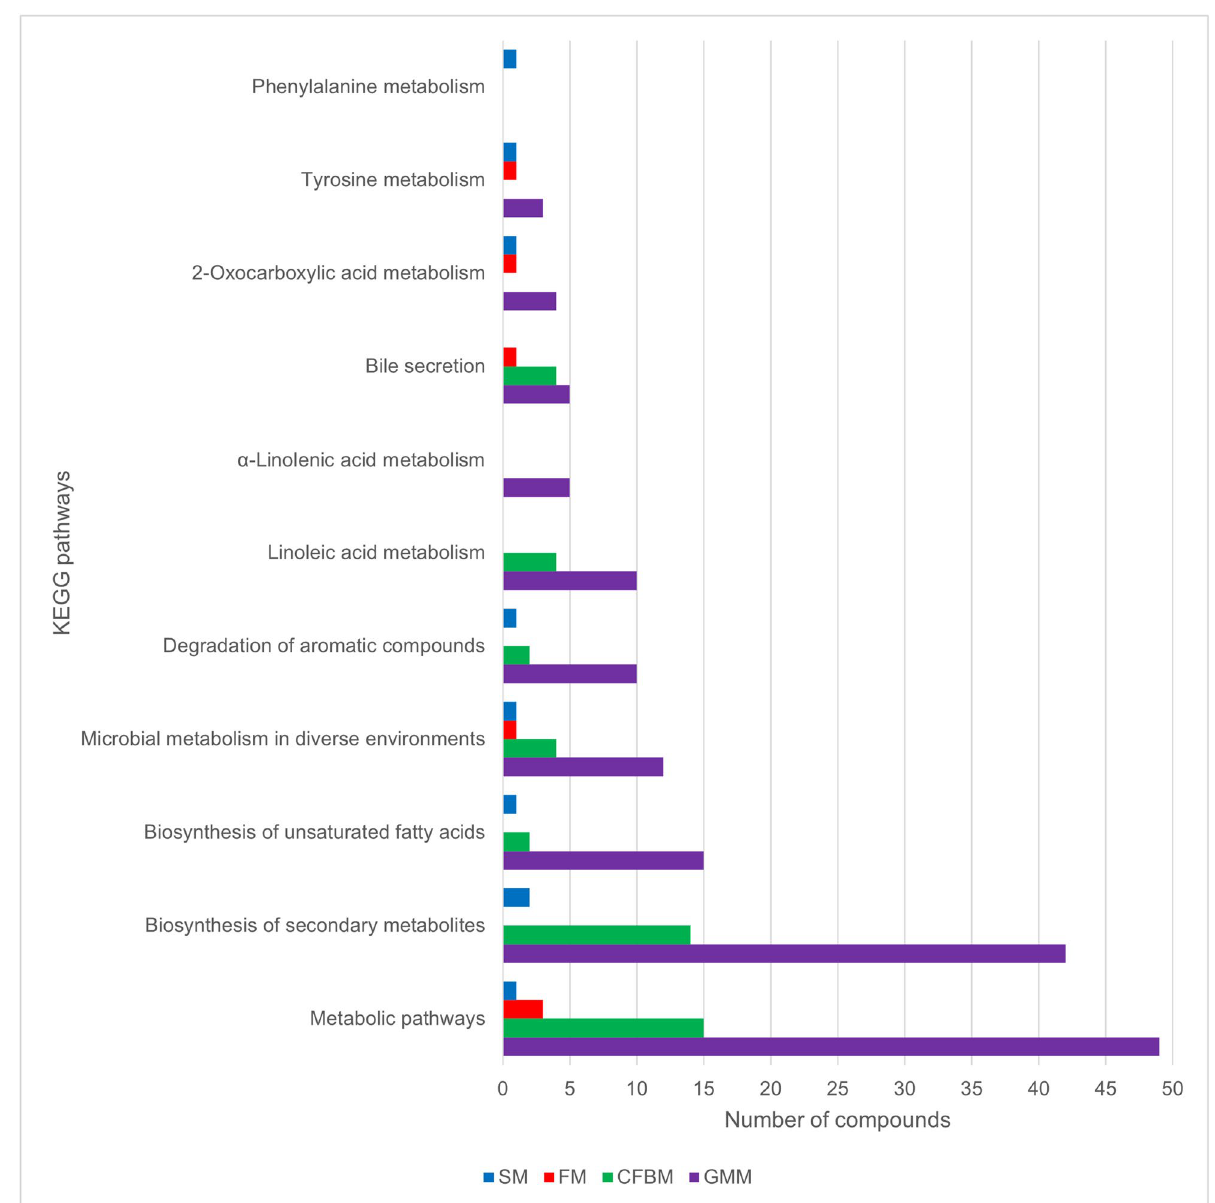
Figure 9. Number of compounds significantly differentiating a given medium (SM, GMM, FM, CFBM) assigned to main metabolic pathways according to the KEGG